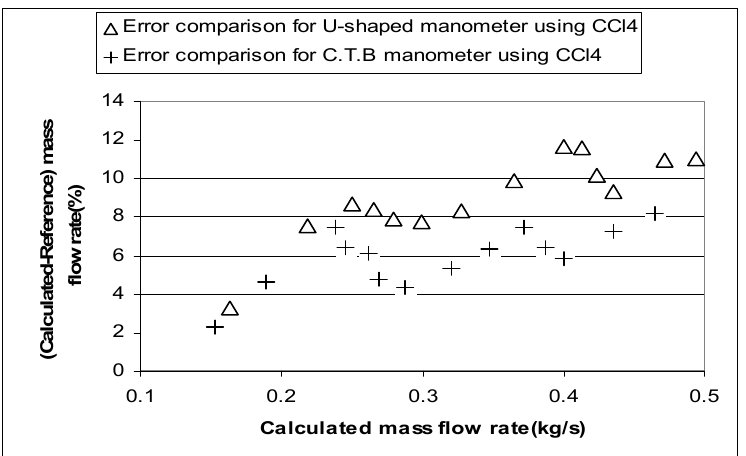
Figure 12 . Error analysis comparison between mass flow rates in case of venturimeter while using CCl